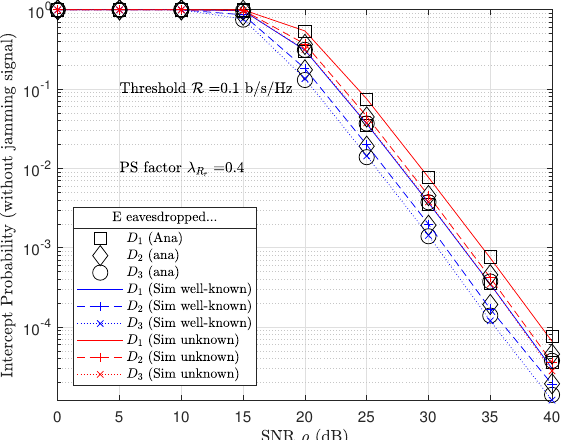
Figure 6. IP performance of cooperative NOMA-IoT network without jamming signal.